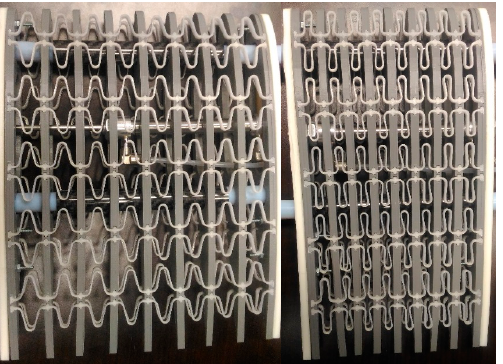
Figure 14. The actuation of the assembled span morphing wing partition ( left ) extended, ( right ) compressed.